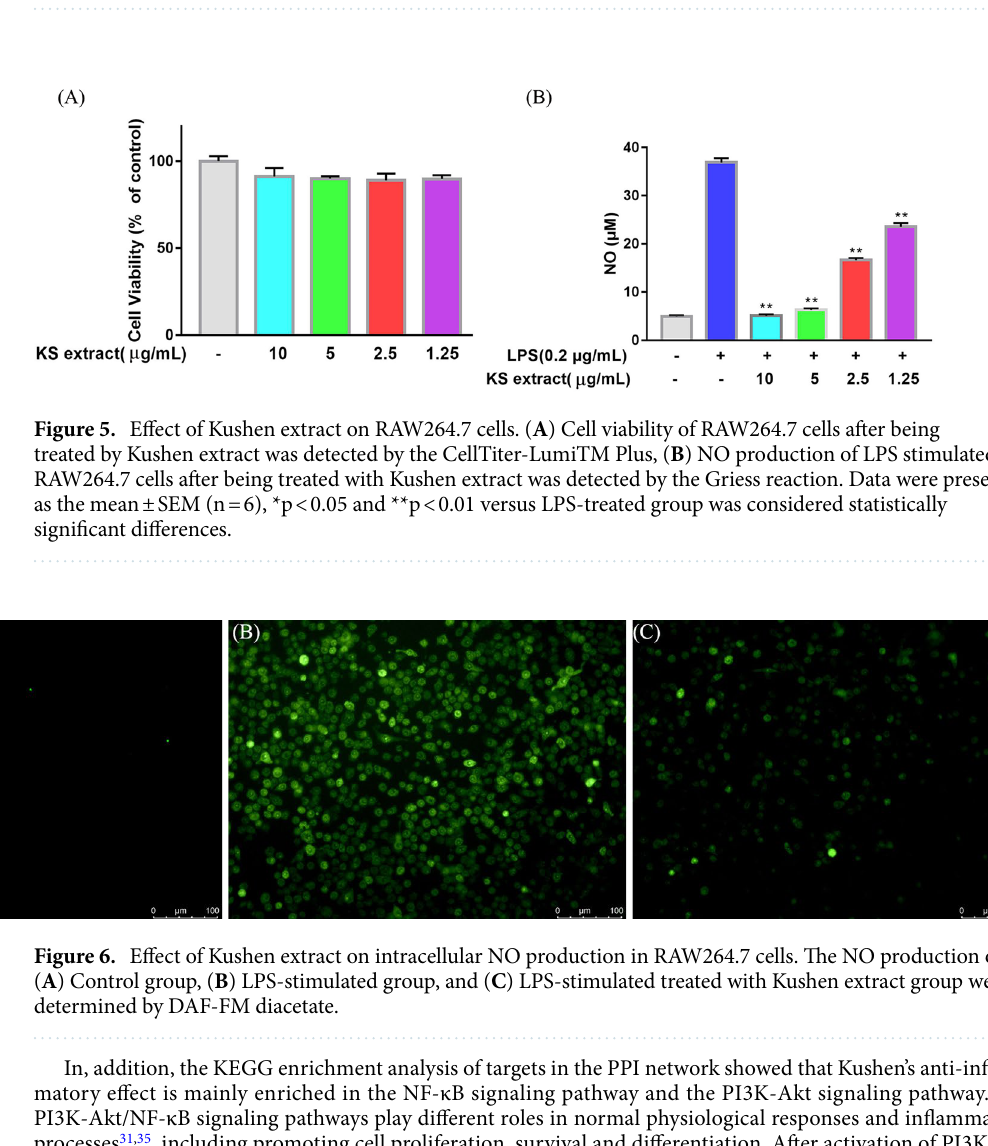
Table 3. KEGG pathway enrichment analysis.